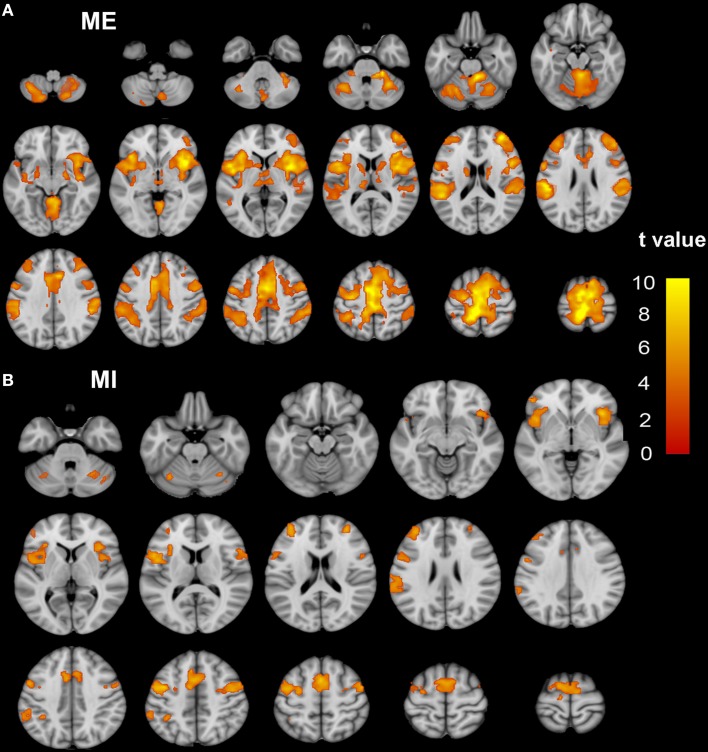
The activation patterns of the ME and MI tasks in the NC group. Typical brain regions with activation during an ME task are shown in (A), while brain regions with activation during an MI task are shown in (B). Significant activation is considered to correlate to a voxel-wise threshold of q < 0.01 (FDR correction) and a cluster ≥30 voxels. The right side of the image corresponds to the right hemisphere. The color bar represents the t-values. ME, motor execution; MI, motor imagery; NC, normal controls.